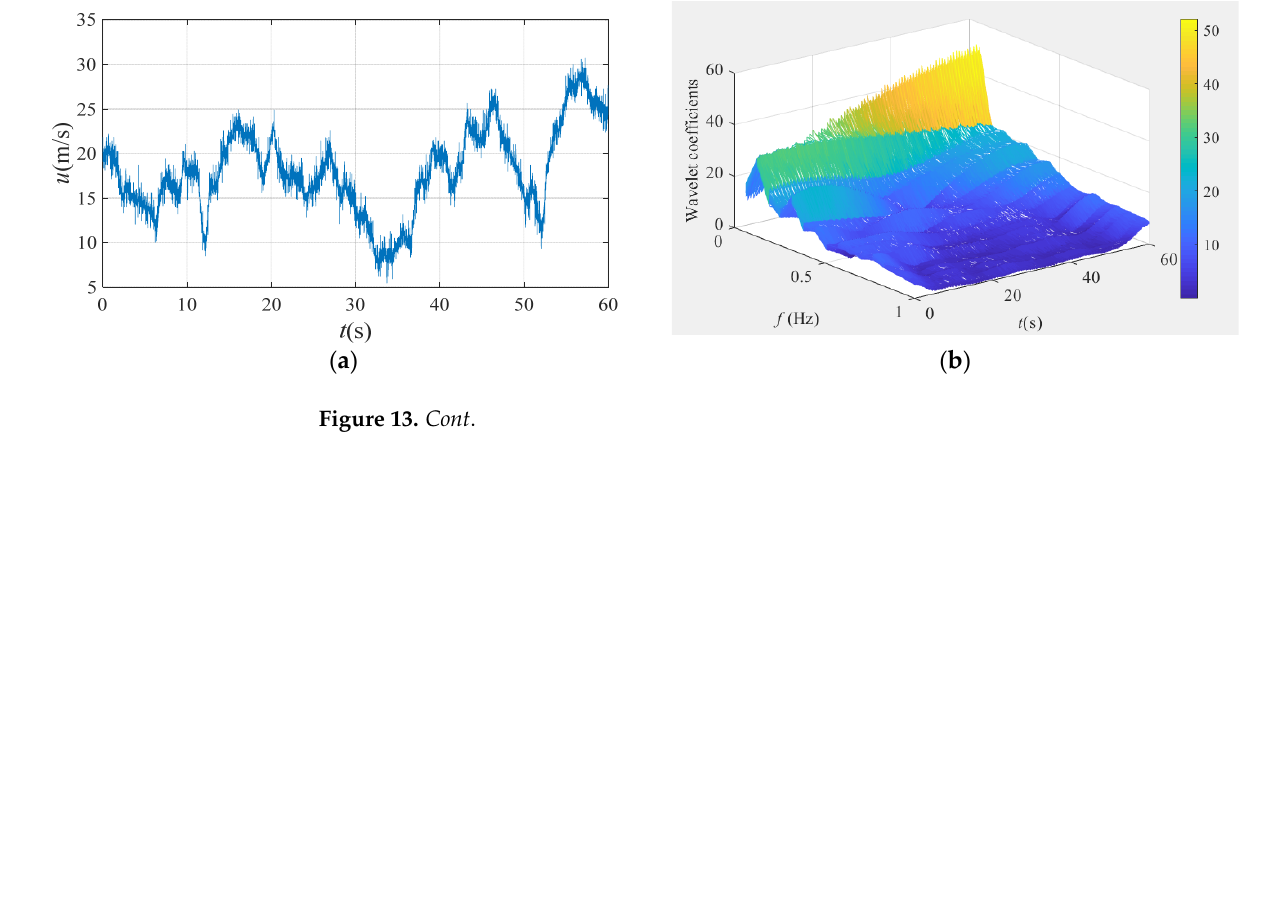
Figure 12. Power spectrum of wind speed during Typhoon Sarika. ( a